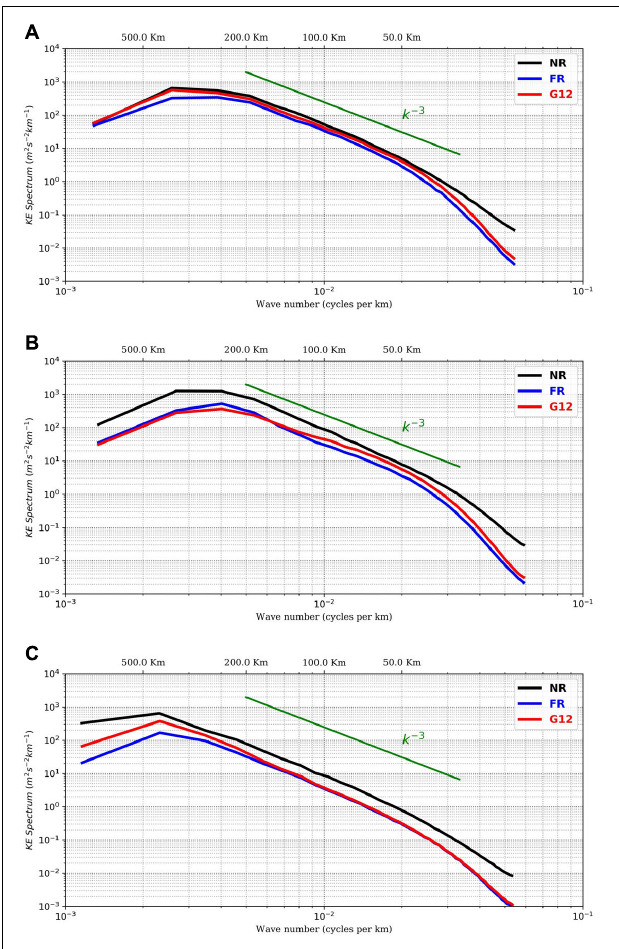
FIGURE 1 | Surface KE (Kinetic Energy, 2015 mean) Spectrum in three panels (A) Kuroshio Current (130–140 ◦ E; 15–25 ◦ N), (B) Gulf Stream Current (75–65 ◦ E; 25–35 ◦ N), and (C) Tropic area (22–11 ◦ E; 7 ◦ S–7 ◦ N). Blue curve for FR, red curve for G12, and black curve for NR.